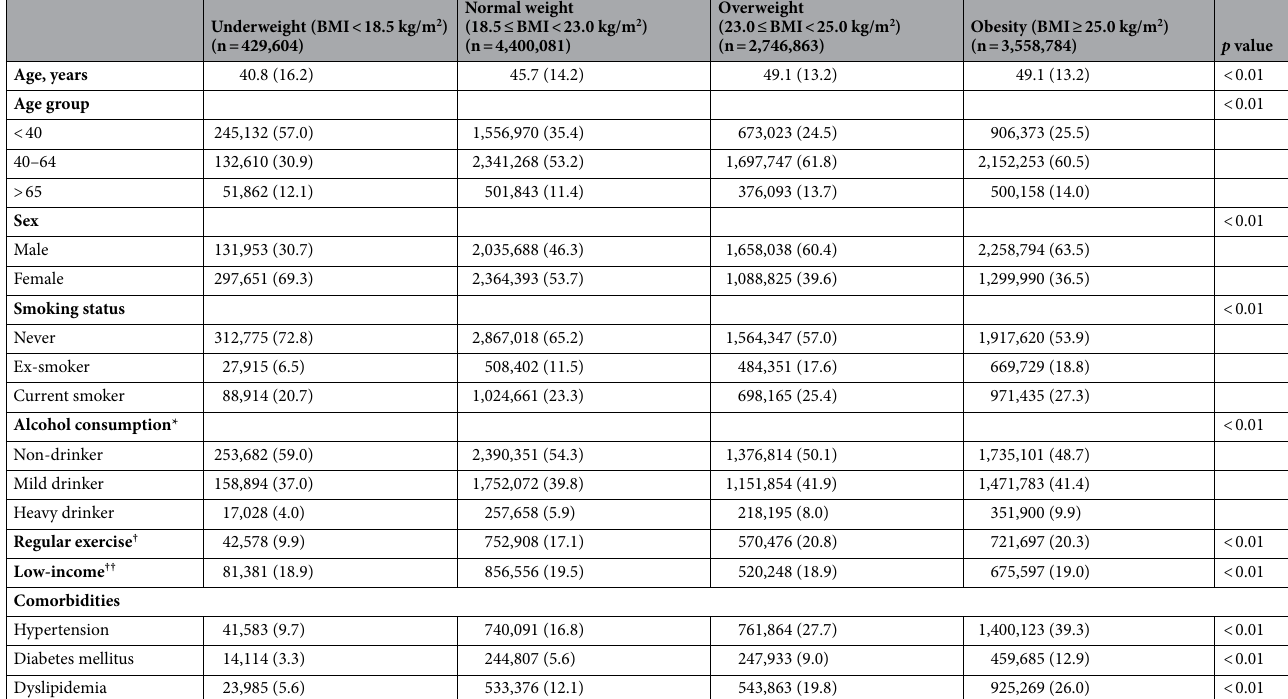
Table 1. Baseline characteristics of the study population. Data are presented as the mean (SD) and number (%) BMI body mass index. *Alcohol consumption was classified into mild drinker (less than 30 g/day of alcohol) and heavy drinker (30 g/day or more than 30 g/day of alcohol). † Regular exerciser was defined as individuals who did vigorous activity (> 20 min/day) at least three times per week or moderate activity (> 30 min/day) at least five times per week. †† Low-income participants were defined as health insurance premiums less than the lowest quintile in the insured or medical aid beneficiaries.